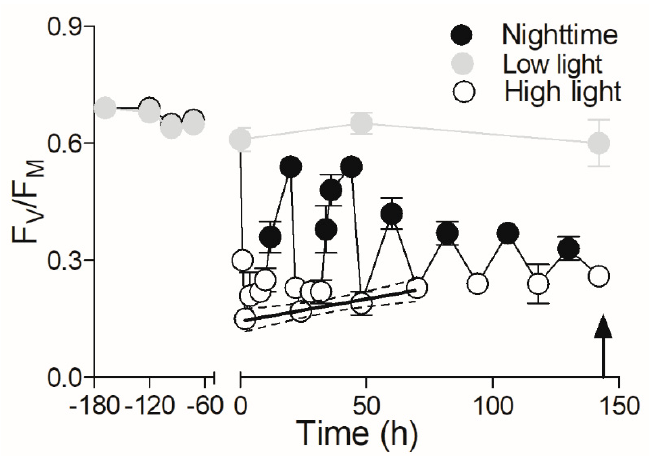
Figure 1. Diagram of an exemplary change in maximum photochemical quantum yield (F V /F M ) of photosystem II (PSII) of a culture grown in low light (35 µ mol photons m − 1 s − 1 ) and after an upward-shift light (250 µ mol photons m − 1 s − 1 ). The fitted line of F V /F M obtained 2 h after the light being turned on with 95% confidential intervals indicates the recovery of cells from stressful high light. Points show the averages of the F V /F M of three independently grown cultures, and error bars show the standard deviations ( n = 3), often within symbols. The arrow indicates the timepoint of taking samples for biological and chemical measurements. This example of F V /F M variation was taken from a culture of T. pseudonana growing in an 88.2 µ M nitrogen